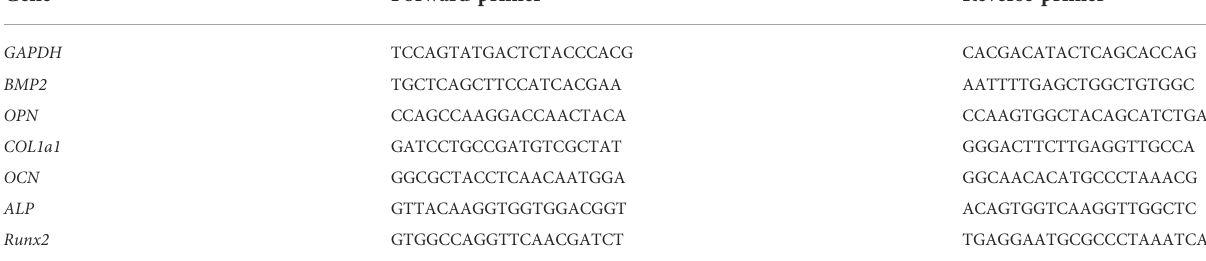
TABLE 1 Primers used for the qRT-PCR